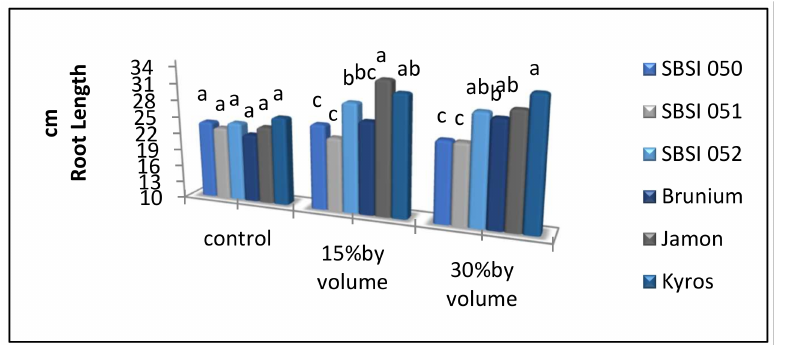
Figure 8. The interaction effects of methanol × genotype on root length. Means followed by the same letter(s) is/are not significantly differ at 5% level of